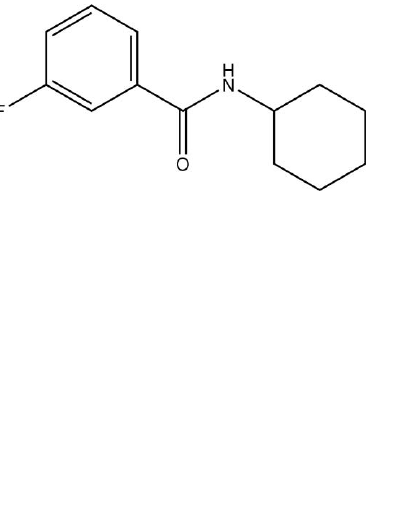
publication: SHELXTL